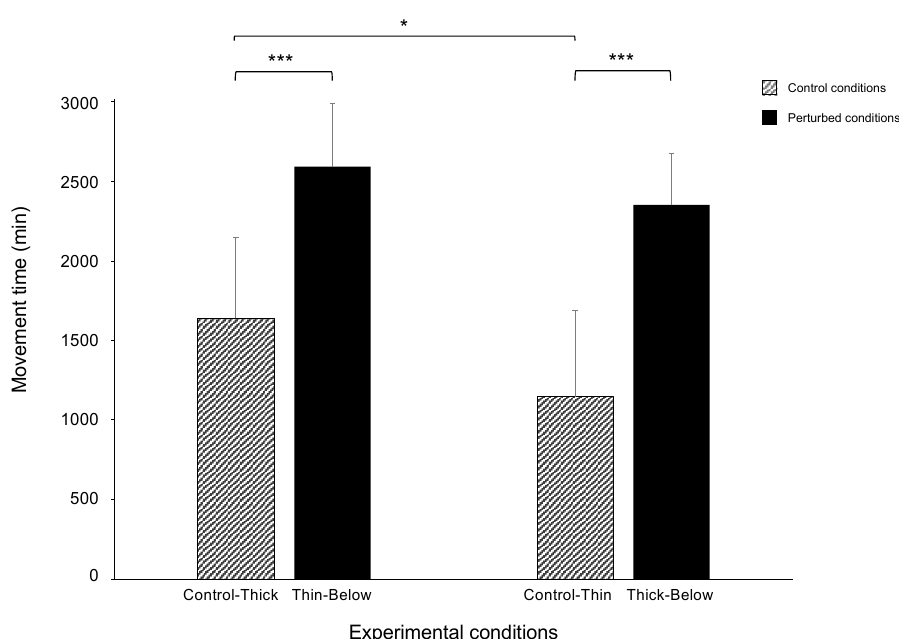
Figure 4. Bar plots representing movement time during the ‘Control-Thick’ and ‘Thin-Below’ support conditions and during the ‘Control-Thin’ and ‘Thick-Below’ support conditions. The bars refer to the median; the error bars refer to the absolute deviation (MAD). The asterisks indicate when the difference between the perturbed and the control conditions was significant. Please note that movement duration was longer for the ‘Control-Thick’ than for the ‘Control-Thin’ conditions and they were longer for the perturbed (i.e., ‘Thin-Below and ‘Thick-Below’ support) than for the control conditions. * = p < 0.05; *** = p < 0.001.